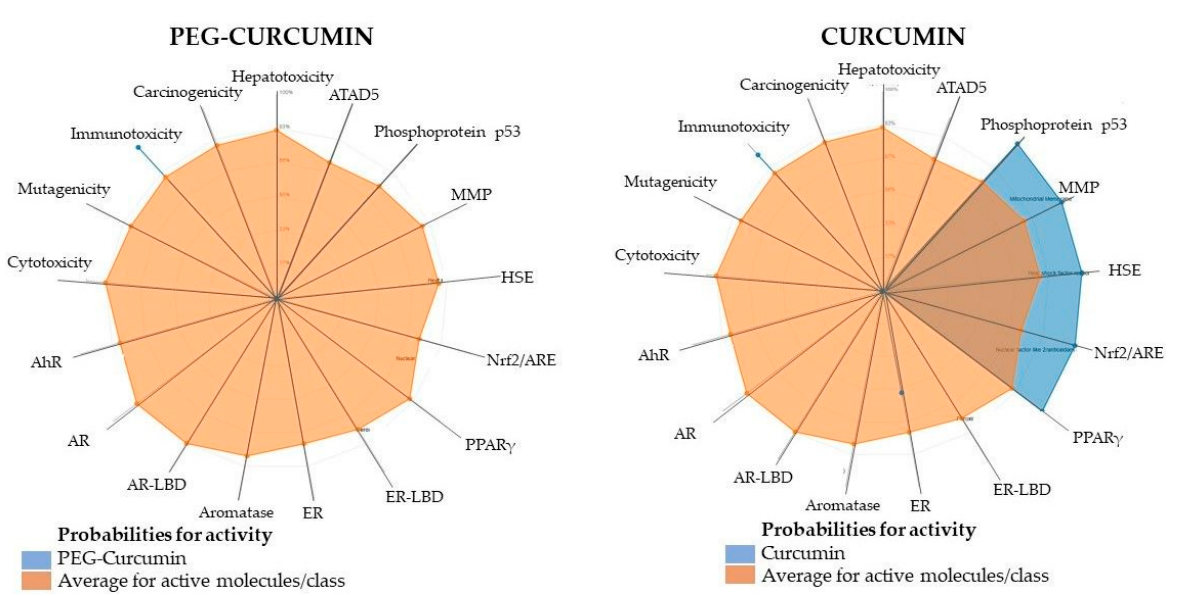
Figure 16. Toxicity radars for compound 5 and curcumin. The orange dots/lines represent the pre- dicted probabilities of the input structure for corresponding ProTox-II models. The predicted toxicity result is created by comparing the average confidence score of the active compounds in the training set of each model, to that of the input compounds (compound 5 and curcumin). Abbreviations: AhR, aryl hydrocarbon receptor; AR, androgen receptor; AR-LBD, androgen receptor ligand-binding domain; ATAD5, ATPase family AAA domain-containing 5; ER, estrogen receptor; ER-LBD, estrogen receptor ligand-binding domain; HSE, heat shock factor response element; MMP, mitochondrial membrane potential; Nrf2/ARE, nuclear erythroid 2-related factor 2/antioxidant response element; PPAR γ , peroxisome proliferator-activated receptor.